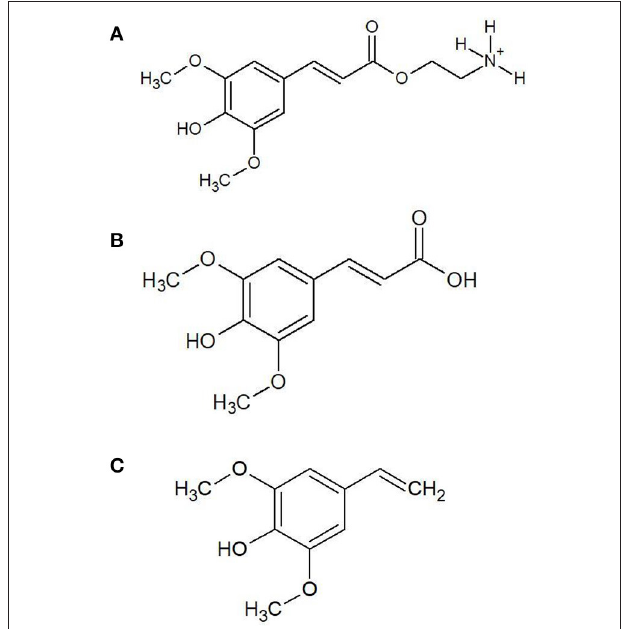
FIGURE 1 | The chemical structures of sinapine (A) , sinapic acid (B) , and canolol (C)